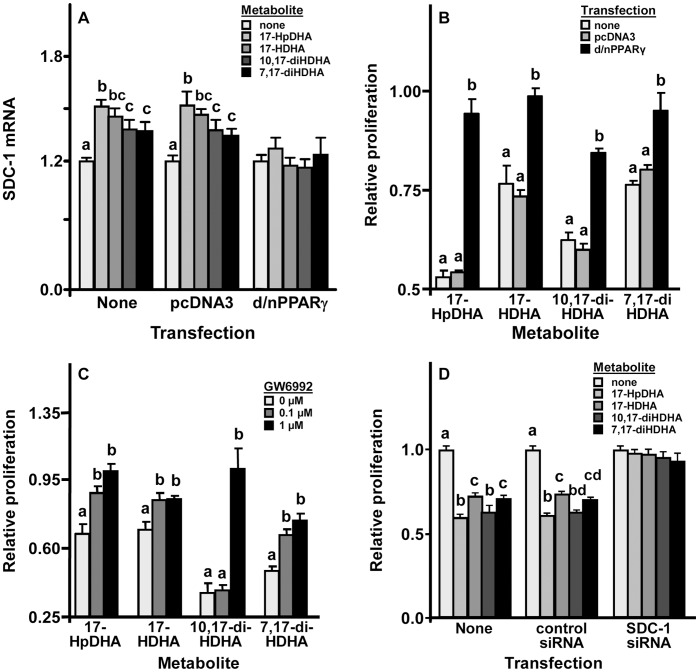
Inhibition of the effects of DHA metabolites in PC3 cells.
A. Cells not transfected or transfected with pcDNA3 or d/nPPARγ were challenged with 10 µM of the indicated metabolite for 24 h before assaying syndecan-1 mRNA. Values represent the mean ± SD (N = 3). Within a transfection group, bars labeled with the same letters are not significantly different from each other; bars labeled with different letters are significantly different from each other (one-way ANOVA, P<0.05). B. Cells untransfected or transfected with pcDNA3 or d/nPPARγ were challenged with 10 µM of the indicated metabolite for 3 days before assaying proliferation. Values represent the mean ± SD (N = 3). Within a metabolite group, bars labeled with the same letters are not significantly different from each other; bars labeled with different letters are significantly different from each other (one-way ANOVA, P<0.05). C. Cells were incubated with 0–1 µM of PPARγ antagonist, GW6692, for 30 min and with 10 µM of the indicated metabolite for 3 days before assaying proliferation. Results are presented as mean ± SEM (N = 3 independent experiments). Within a metabolite group, bars labeled with the same letters are not significantly different from each other; bars labeled with different letters are significantly different from each other (one-way ANOVA, P<0.05). D. Cells untransfected, transfected with control siRNA, or transfected with SDC-1 siRNA were challenged with 10 µM of the indicated metabolite for 3 days before assaying proliferation. Results are presented as mean ± SD (N = 4). Within a transfection group, bars labeled with the same letters are not significantly different from each other; bars labeled with different letters are significantly different from each other (one-way ANOVA, P<0.05).